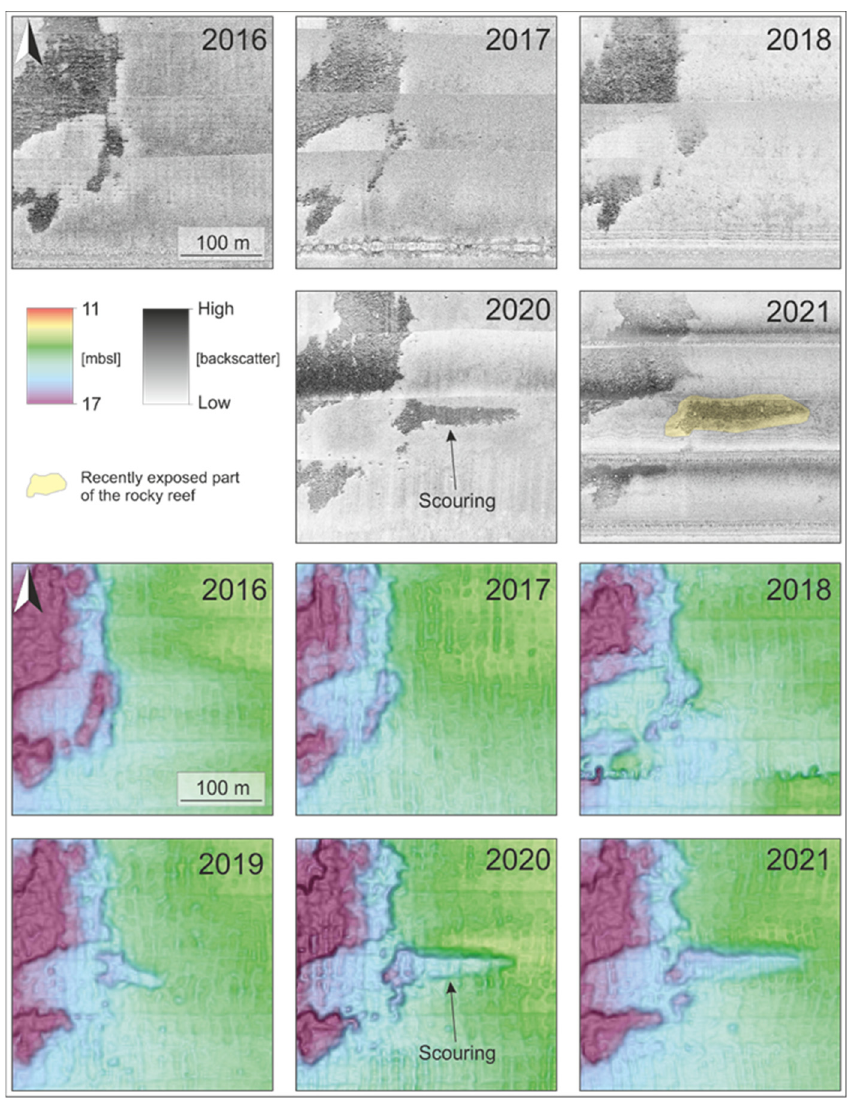
Figure 3. Closeup of side-scan backscatter ( top ) and multibeam bathymetry ( bottom ). The east side of the working area shows the migration of sand and the scouring around newly exposed boulders over a six-year time span.